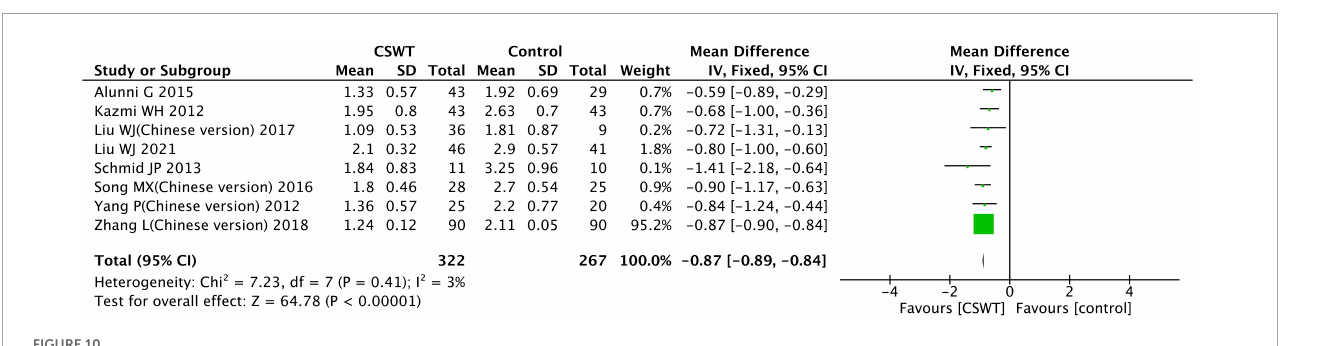
FIGURE10 Forest plot of the CSWT group vs. the control group-CCS